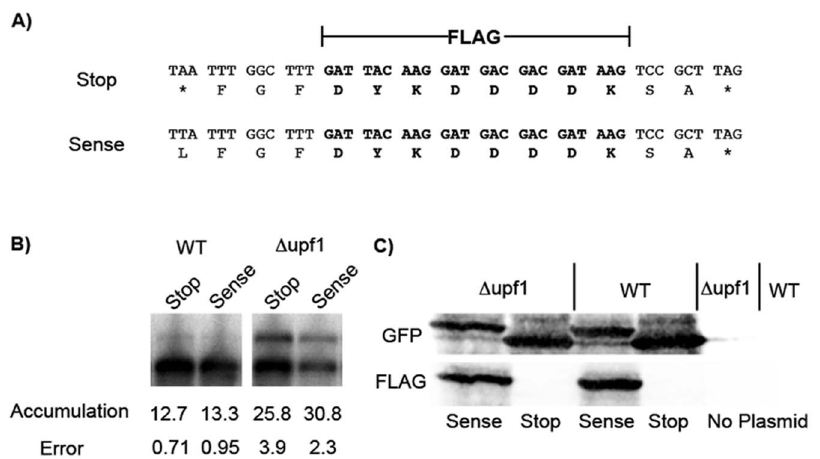
Figure 6. 3 9 UTR targeting is not associated with extensive translational read-through. ( A ) A FLAG tag was inserted three codons downstream of the normal stop codon of the GFP-MSH4 3 9 UTR construct to monitor translational read-through. The normal TAA (stop) codon was also mutated to the sense codon TTA (Leu) as a positive control. The * indicates a stop codon. ( B ) Northern blots were performed to measure relative accumulation of the NMD sensitive transcript in a wild type and NMD deficient strain. The presence of the FLAG sequence or stop R sense mutation did not affect relative accumulation of the mRNA. ( C ) Western blot of the GFP-FLAG-MSH4 3 9 UTR fusion. No translational read-through product was detected in the wild type or NMD deficient